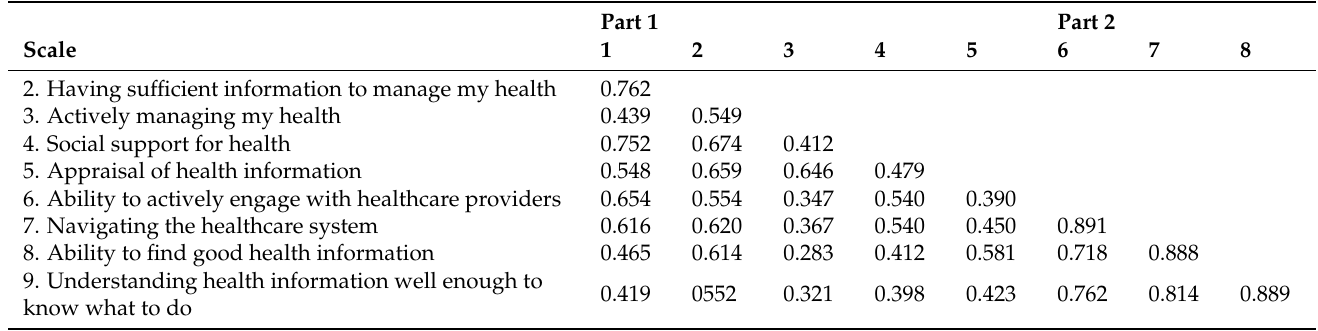
Table 4. Inter-factor correlations among the nine Health Literacy Questionnaire scales derived from a nine-factor confirmatory factor analysis